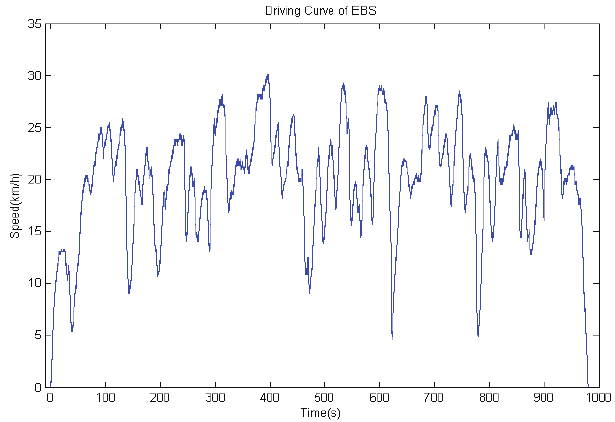
Figure 10. Driving speed curve for the torque and battery distribution strategy in the road test on the campus of Industrial Technology Research Institute.